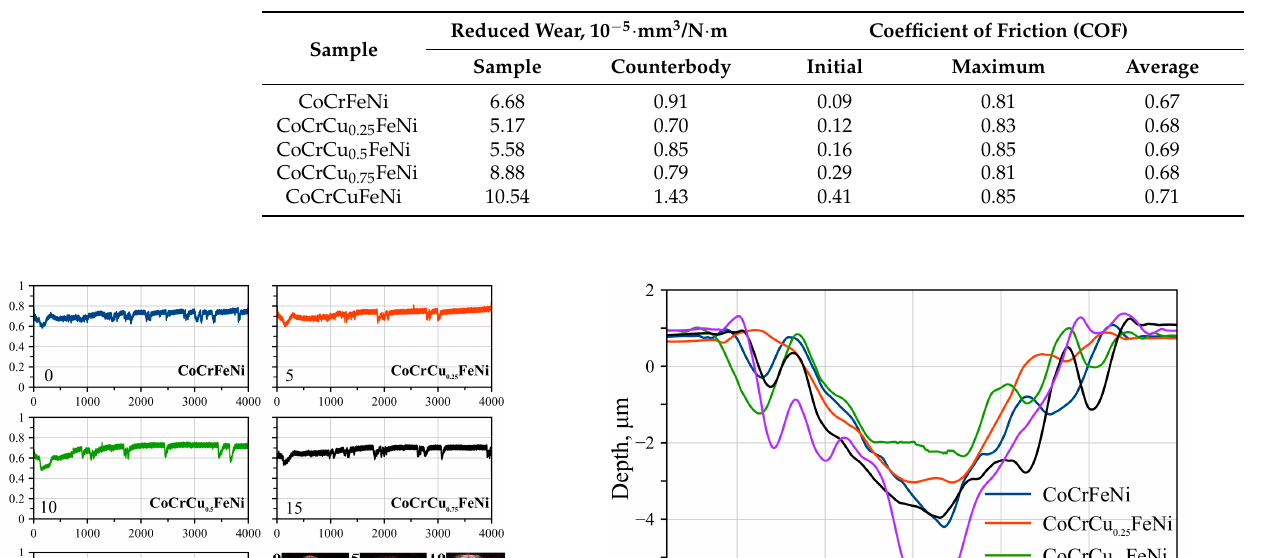
Table 1. Tribological properties of HEAs.